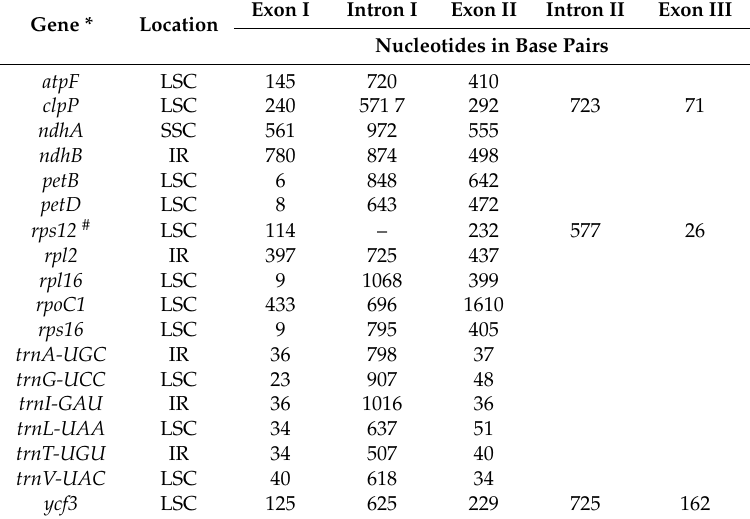
Table 2. Location and length of intron-containing genes within the C. falcatum chloroplast